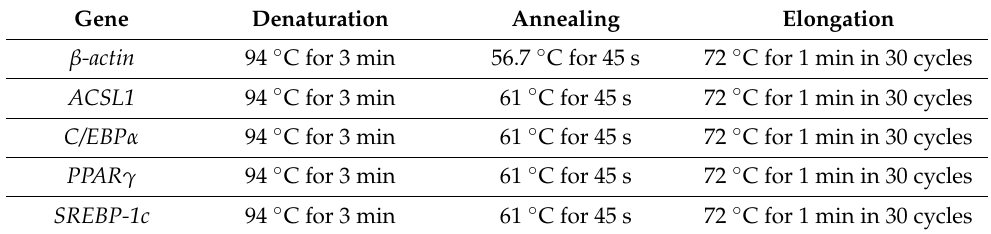
Table 1. PCR conditions for amplification of different genes.